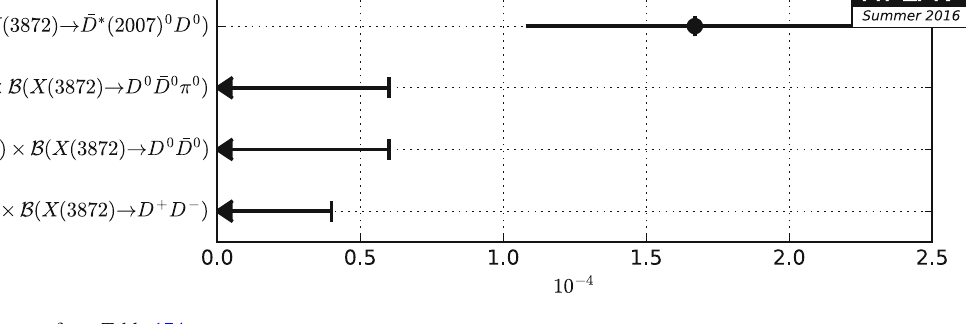
Fig. 141 Summary of the averages from Table 174